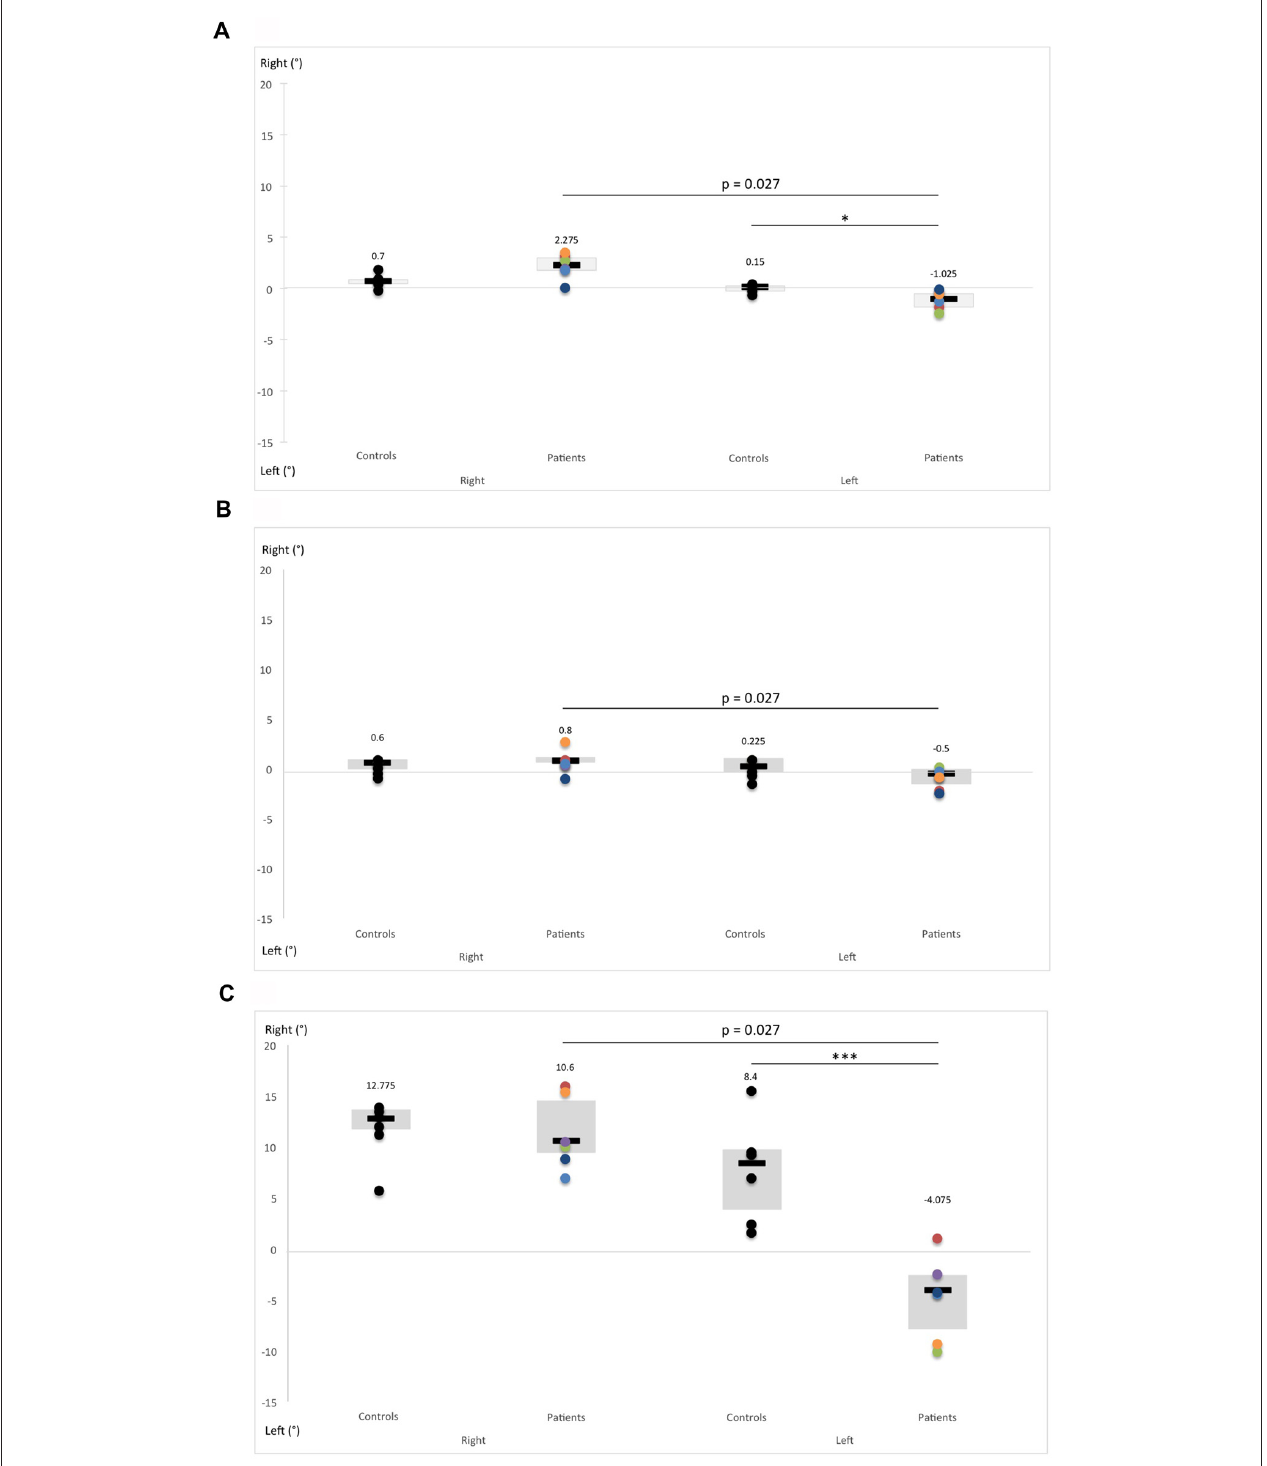
FIGURE 3 | Comparison of subjective visual vertical (SVV) performance between hEDS patients and controls in different body positions: (A) standing, (B) sitting and (C) lying on the right side. SVV was measured by presenting a laser rod 12 times in total darkness with a 30-degree deviation from the vertical alternately on the right and the left. Subjects were asked to reposition the rod vertically using a remote control. Box plots represent median and quartiles, and dots represent performance of each participant as follows: controls: black; patient 1: red; patient 2: green; patient 3: purple; patient 4: light blue; patient 5: orange; patient 6: dark blue. ∗ p < 0.05, ∗∗∗ p <